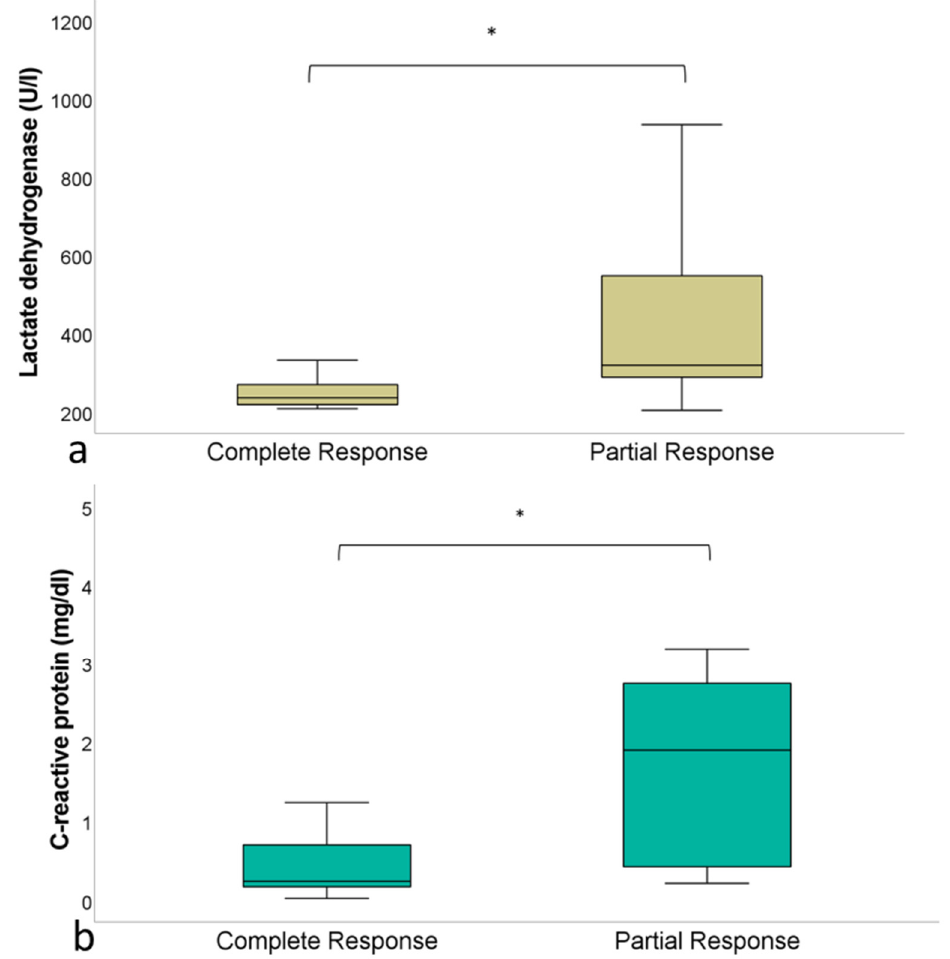
Figure Figure 4. ( a ) Serum LDH at baseline before CAR-T cell therapy in patients achieving CR (240 ± 28 U/L) vs. patients achieving PR (443 ± 262 U/L; p < 0.05). ( b ) CRP at baseline before CAR-T cell therapy in patients achieving CR (2.6 ± 4.6 μ g/dL) vs. patients achieving PR (4.2 ± 6.6 μ g/dL; p < 0.05). The asterisk (*) indicates clinical significance ( p < 0.05).